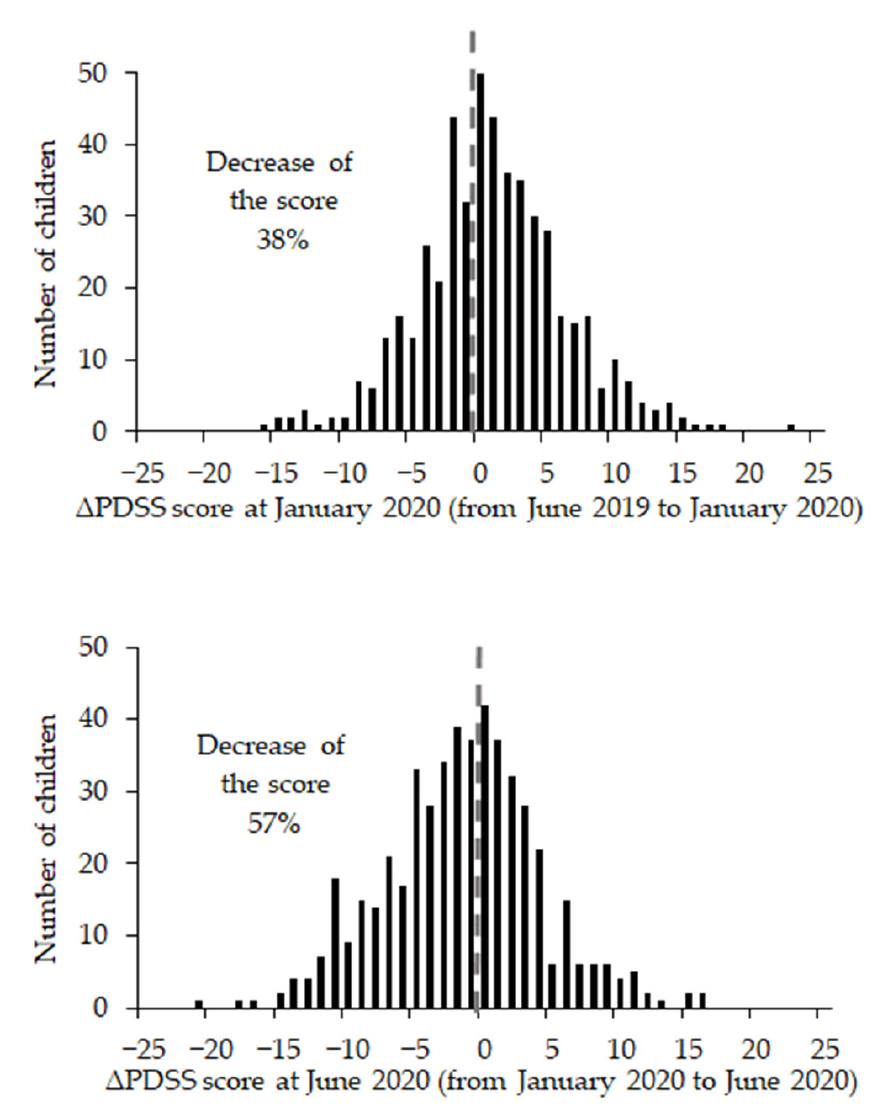
Figure 1. The distribution of ∆ PDSS scores at January 2020 and June 2020. Pupils were categorized into three groups according to the changes in their daytime sleepiness ( ∆ PDSS score) between January 2020 and June 2020, including a